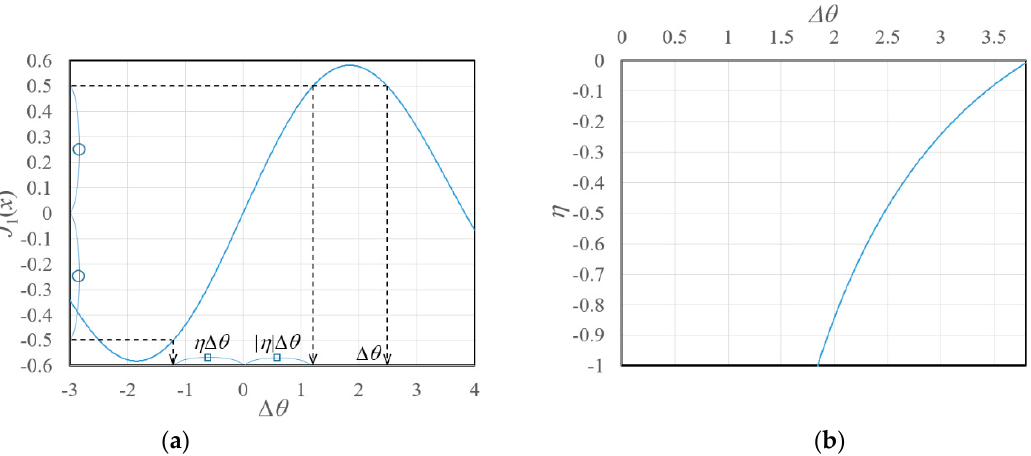
Figure 2. ( a ) A solution of Equation (9) for m = 0 and Δ θ = 2.485, and ( b ) the combination of η and Δ θ satisfying Equation (9).